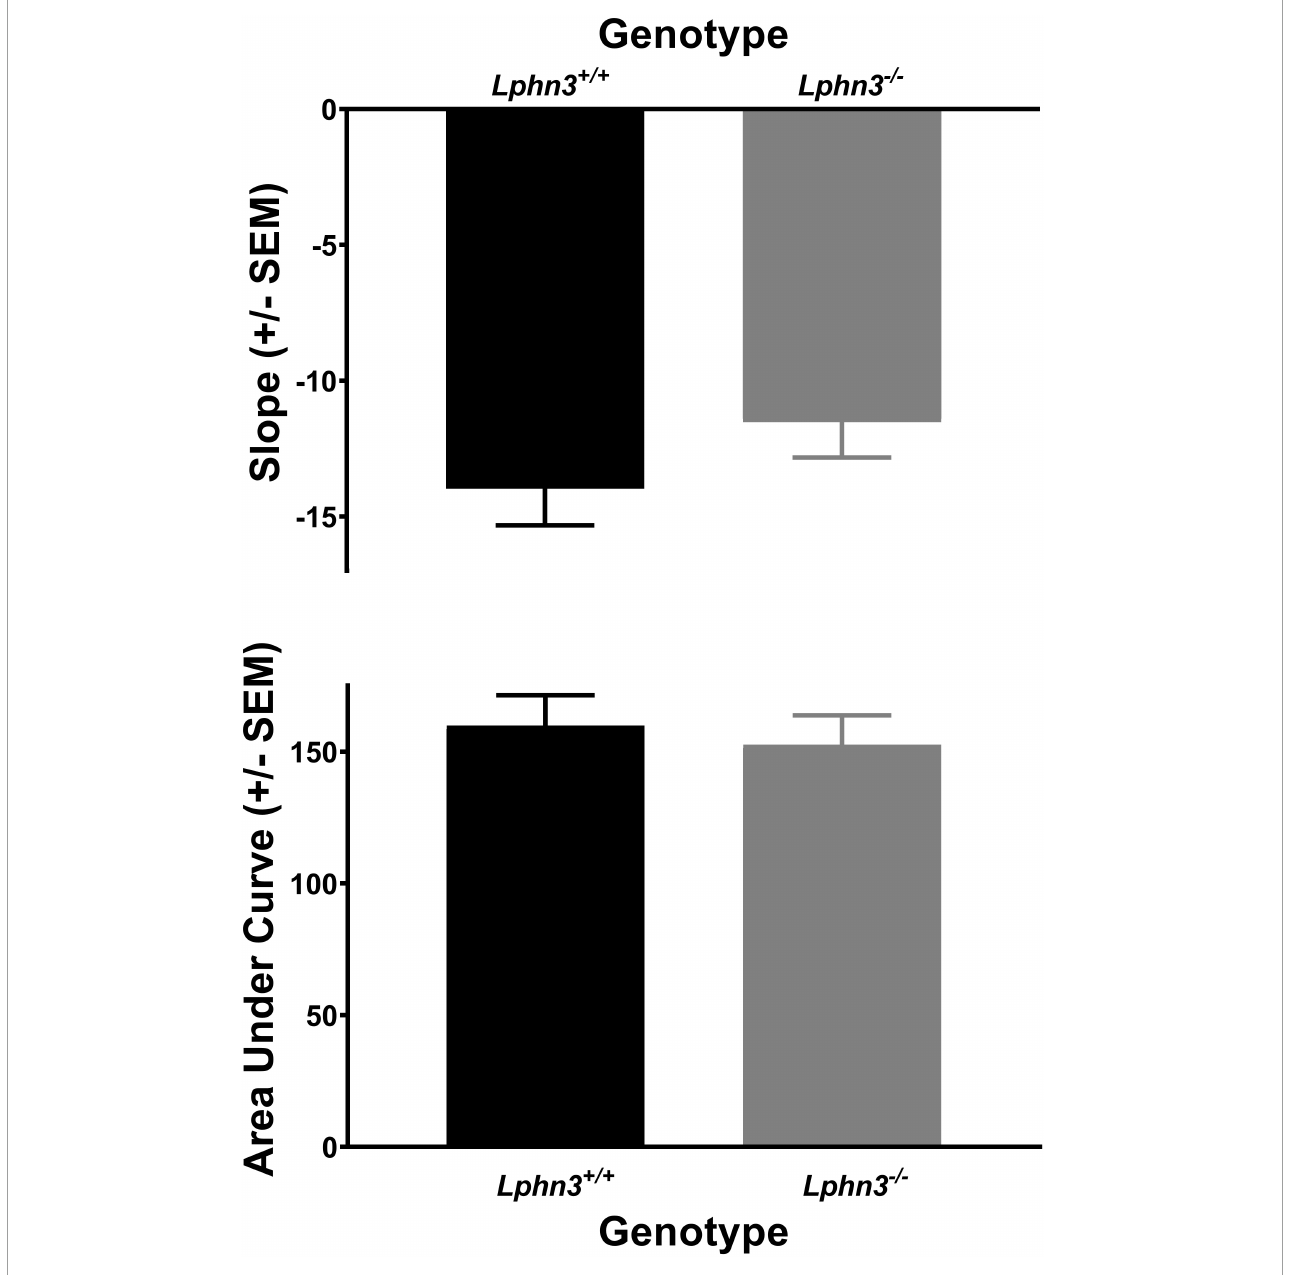
FIGURE4 The slope of the discounting curve (top) and area under the discounting curve (bottom) did not differ between the Lphn3 − / − (knockout) and Lphn3 + / + (wildtype) rats with equal trial